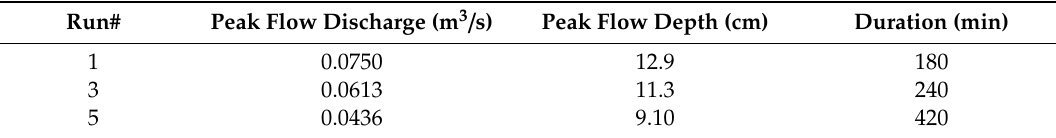
Table 2. Characteristics of the three hydrographs used in this study.